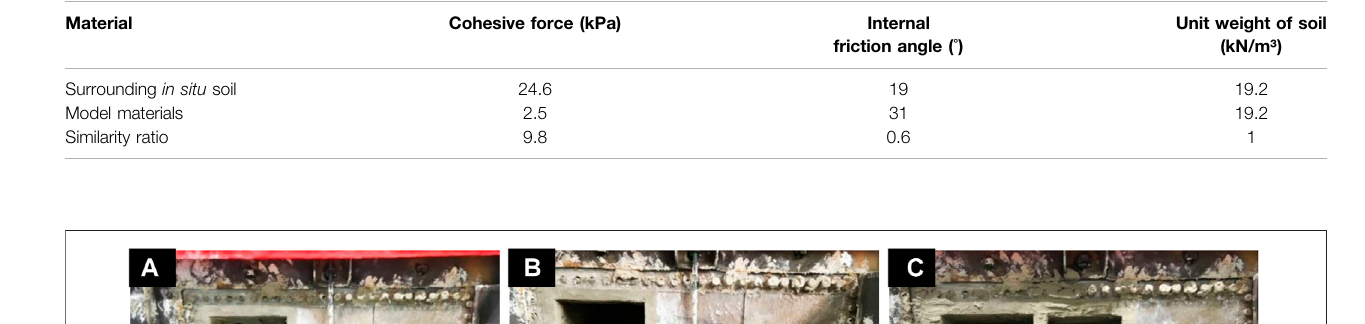
Frontiers in Earth Science |